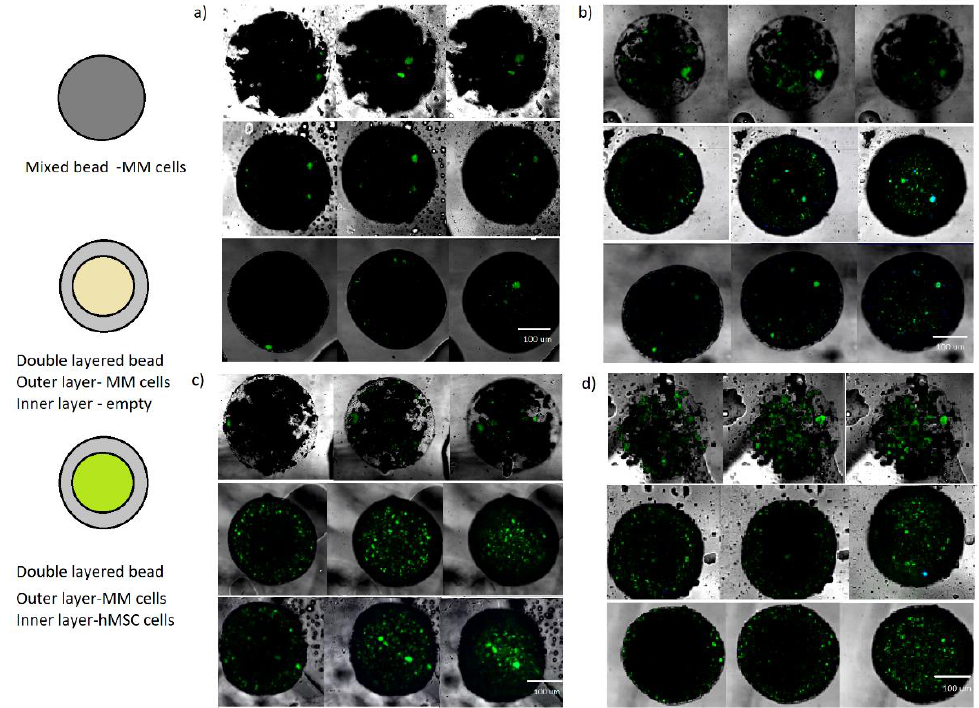
Figure 3. Collected beads after ( a ) 24 h, ( b ) 48 h, ( c ) 72 h, and ( d ) one week. For each case from top to bottom: mixed bead with MM cells, double layer bead with an outer layer of MM cells and empty inner alginate core and double layer bead with an outer layer of MM cells and inner layer of human Mesenchymal stem cells (hMSC) cells. For each case from left to right: different Z plane cuts selected to include the maximum number of positive cells.